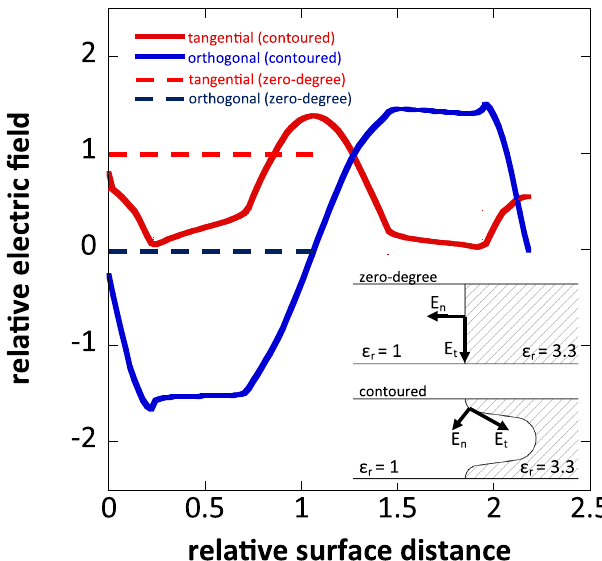
FIG. 6. (Color) Comparison of the 1D calculated tangential and orthogonal components of the electric field along a single groove of the contoured surface profile in Fig. 5 to the tangential and orthogonal field components of a zero-degree insulator of the same axial length. The profiles are for 1-V impressed between the top and bottom surfaces of the legend in the lower right-hand corner. The zero-degree insulator has a surface profile length of 1 and the contoured profile has a surface length of